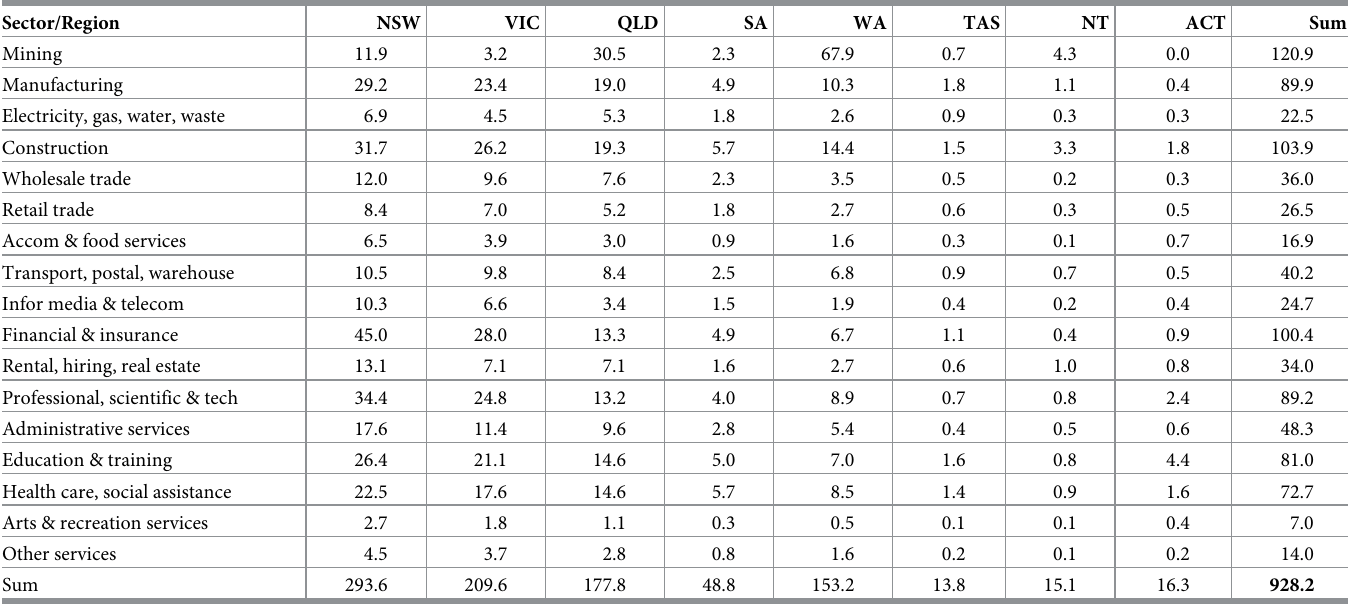
Table 4. Cost of control measures ($ million per day